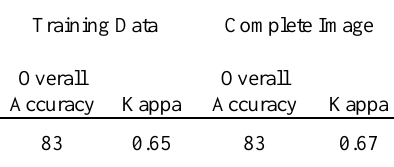
Table 1. Summary of the accuracy achieved for the forest/non- forest classification